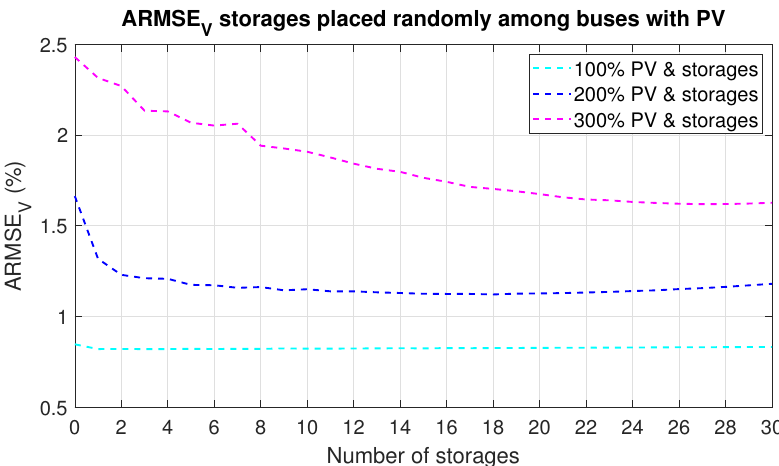
Figure 11. ARMSE of voltage over all buses and over a week for random distribution among nodes with PV units.